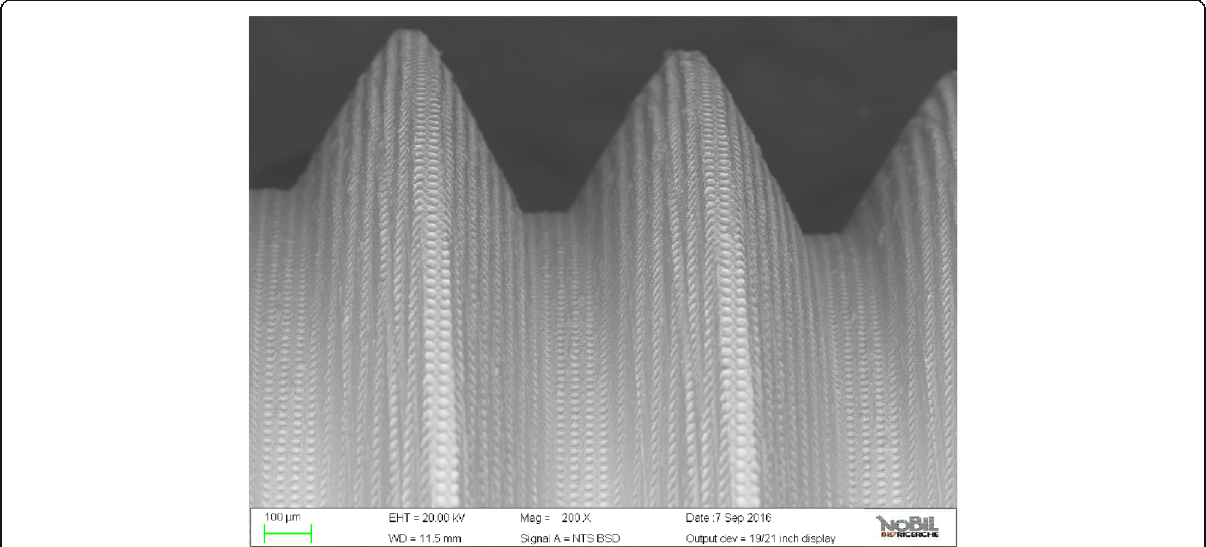
Fig. 5 Scanning electron microscopy (SEM) picture of Synthegra® surface. The laser surface is characterized by a series of 20- μ m-diameter holes (7 – 10 μ m deep) every 10 μ